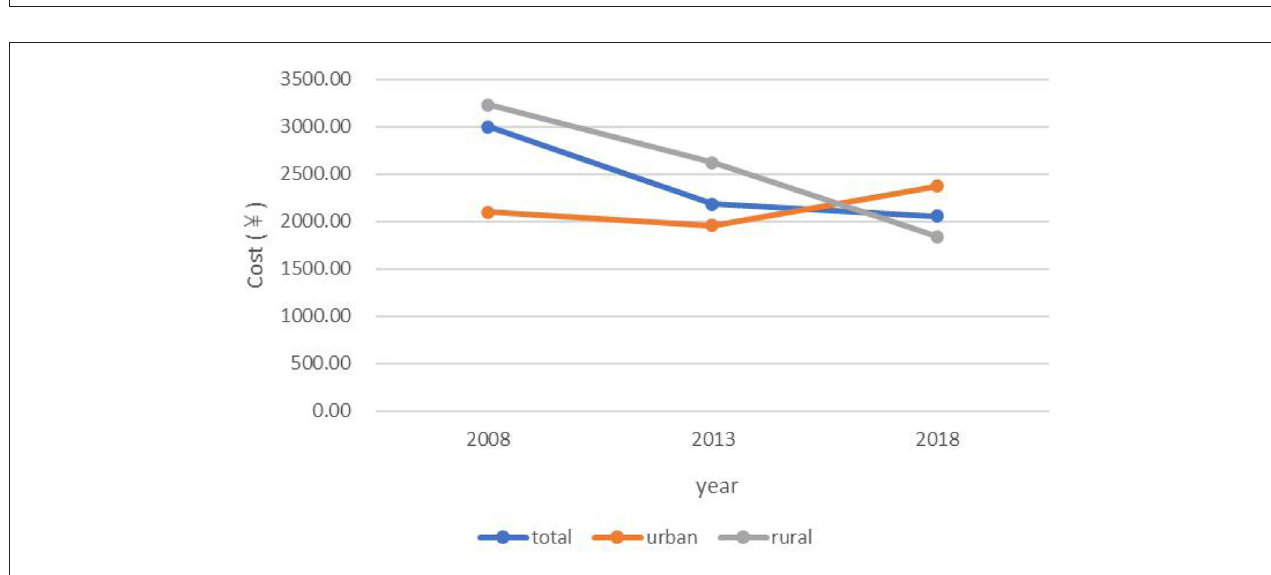
FIGURE 3 | Trends in annual THE among residents of urban and rural areas from 2008 to 2018.